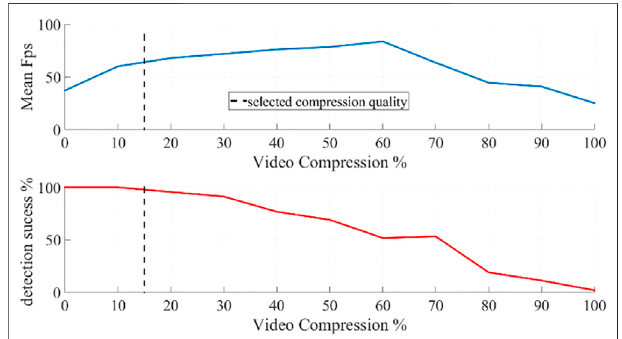
FIGURE 9 | The average speed of image processing to detect the corners of a marker on a single instrument in terms of frames-per-second (upper fi gure) and the rate of correct detection (lower fi gure) with respect to varyingcompressionrateofvideoframestransmittedfromthecamerato the